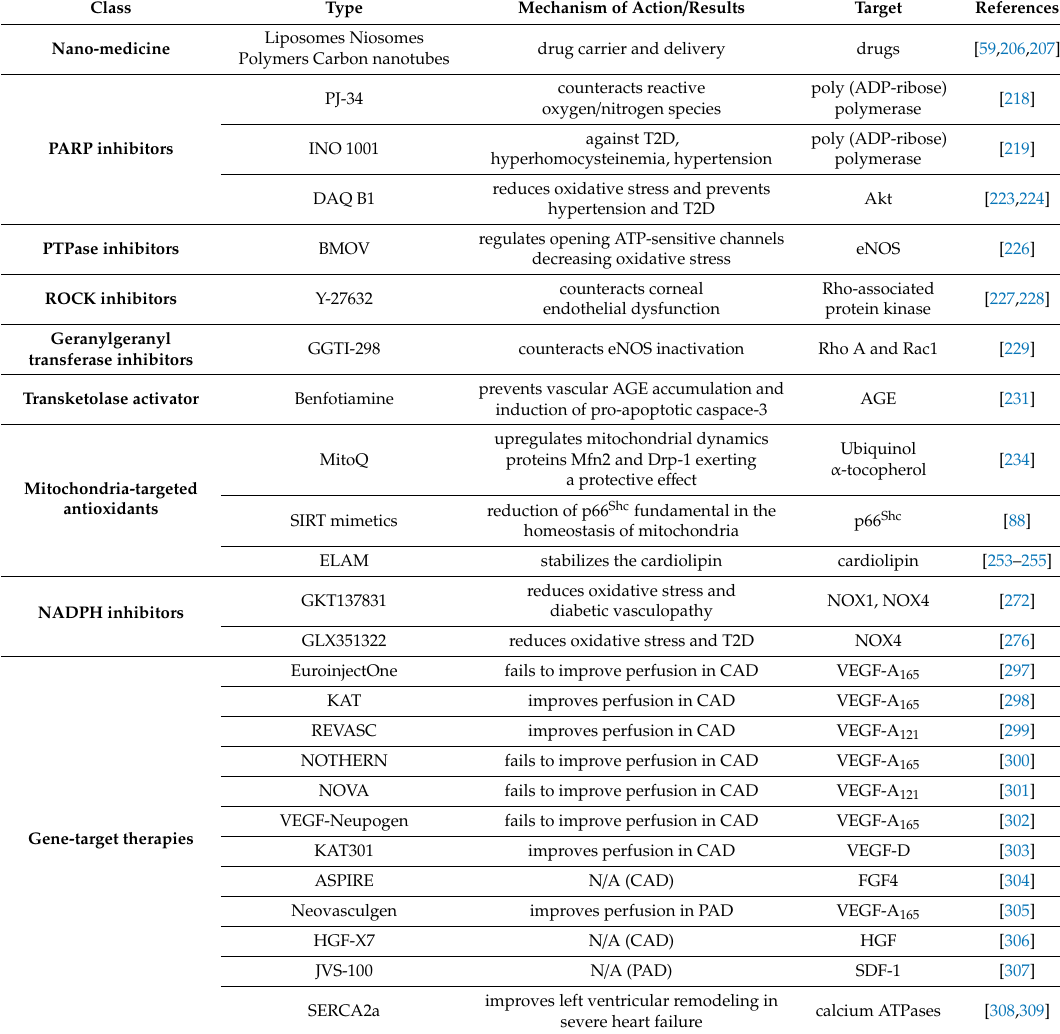
Table 3. New strategies in the clinical treatment of endothelial